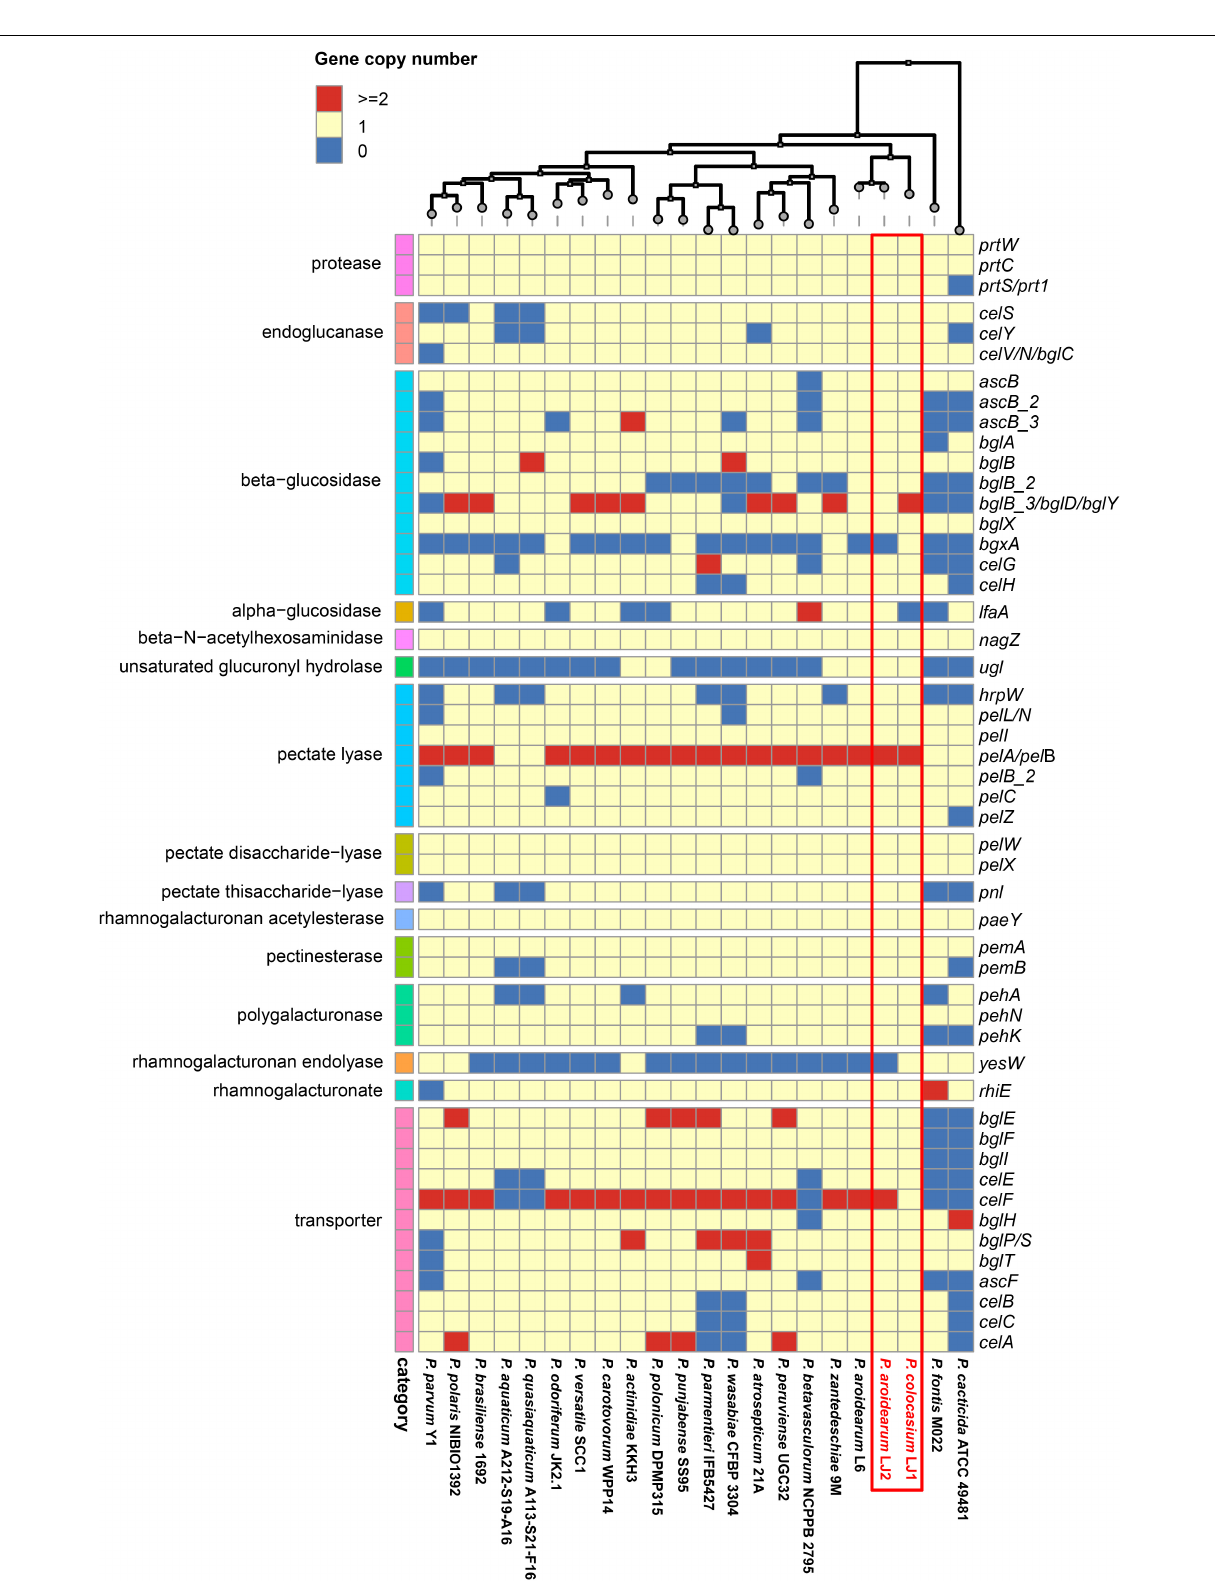
Frontiers in Plant Science |